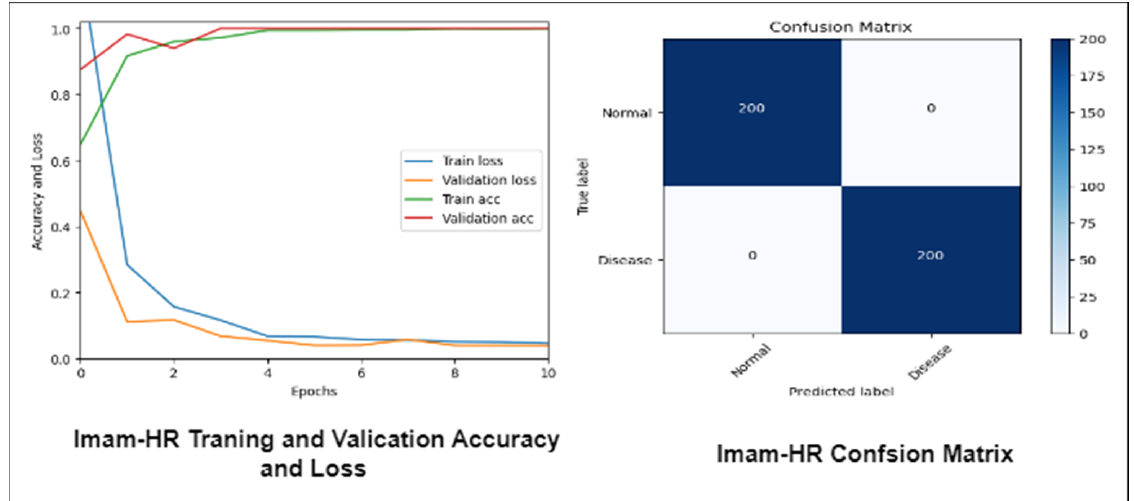
Figure 14. Mobile-HR model’s accuracy, loss, and confusion matrix using the Imam-HR dataset.